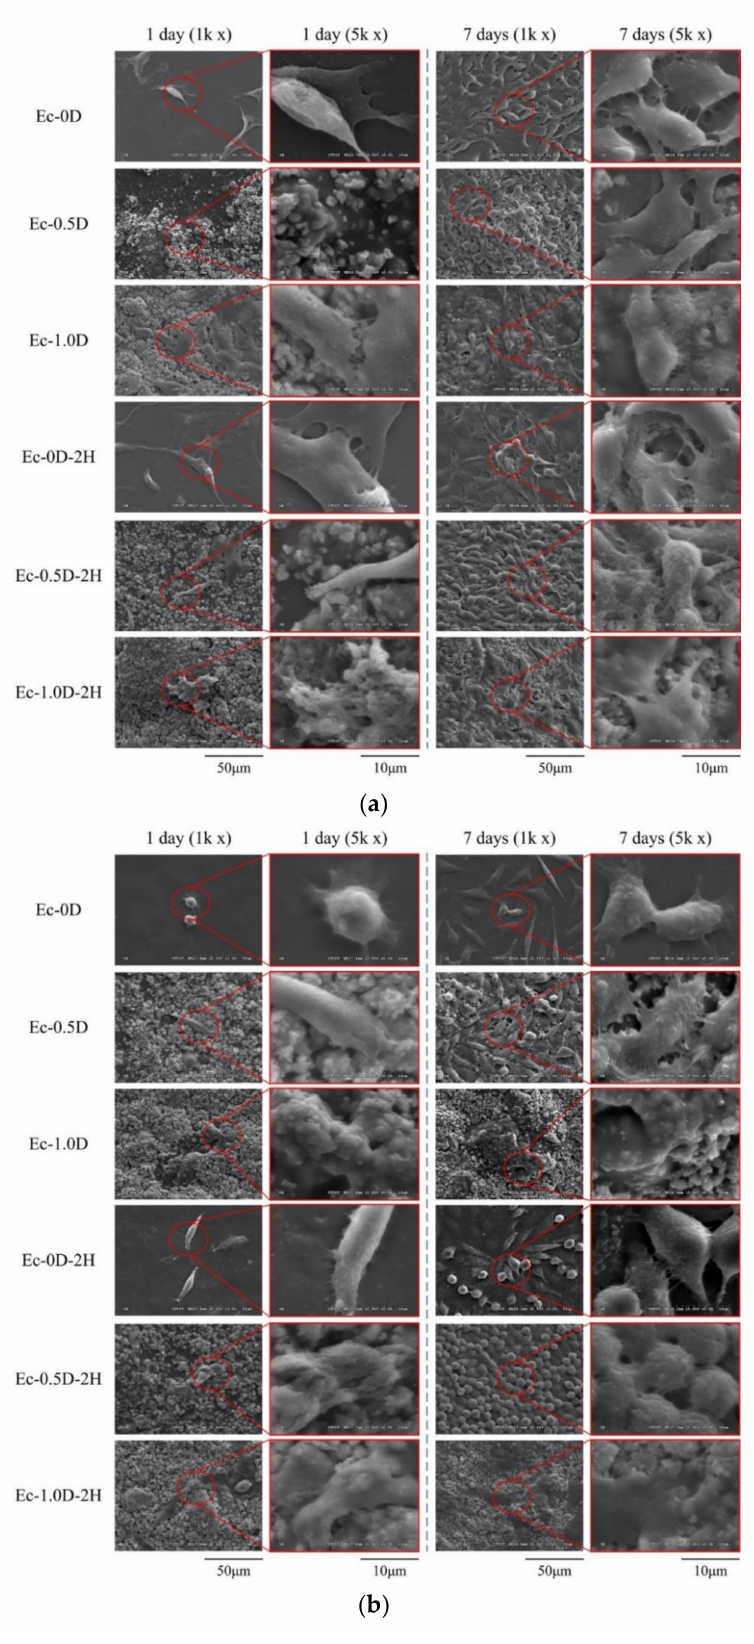
Figure 10. Images of cell attachment on the hydrogel membrane in contact with NIH-3T3 ( a ) and L29 ( b ) cells for 1 day and 7